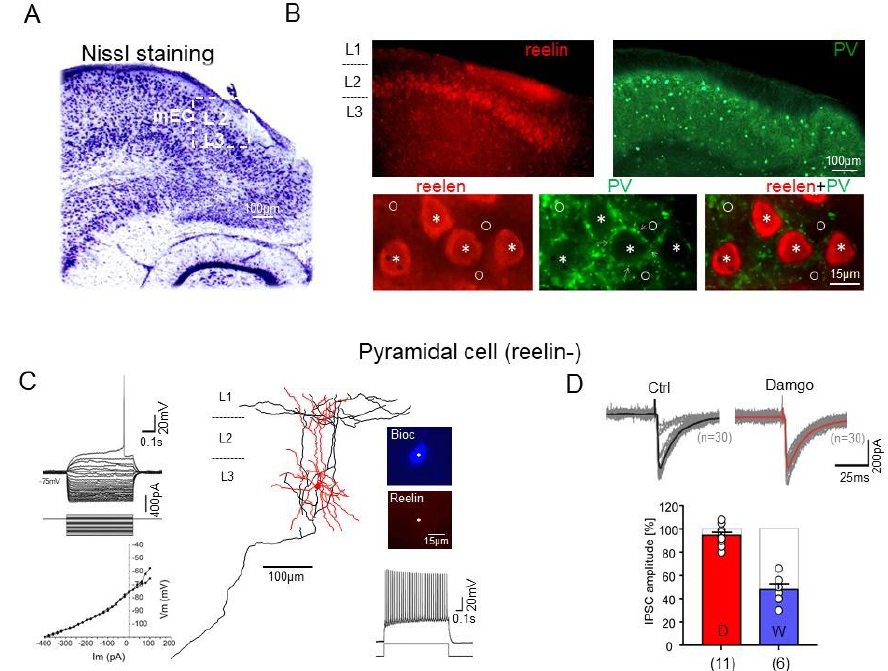
Figure 4. Properties of the mEC L3 pyramidal cells. ( A ). Nissl staining of the EC. ( B ( upper )) Reelin-immunopositive stellate cells ( left , ‘reelin’) and PV-immunopositive interneurons ( right , ‘PV’) in superficial mEC. ( B ( bottom )) PV-immunopositive axon terminals ( middle , ‘PV’, arrows) surround the somata of both reelin-immunopositive (asterisks) and reelin-immunonegative (circle) principal cells in superficial mEC. ( C ) Morphology of a biocytin-filled L3 reelin-negative (reelin-, middle ) PC. Examples of the voltage responses ( C , left , upper ) upon hyperpolarizing and depolarizing current injection and corresponding current – voltage (I – V) relations ( left , bottom ) for each voltage response in C . Note, no sag potential and later rheobase firing of PC ( C , left ). Firing of this cell upon depolarizing 280 pA current injection ( right , bottom ). The PC was immunonegative for reelin (reelin − , C , right , upper ). ( D ) Effects of μ -opioid receptor agonist damgo on the inhibitory transmission in reelin-negative PC ( upper ). The stimulation-evoked IPSCs were slightly, but not significantly, affected in these cells. The corresponding summary bar charts of the peak amplitudes of IPSCs obtained after application of the opioid (in red) and cannabinoid (in blue) receptor agonists ( bottom ).